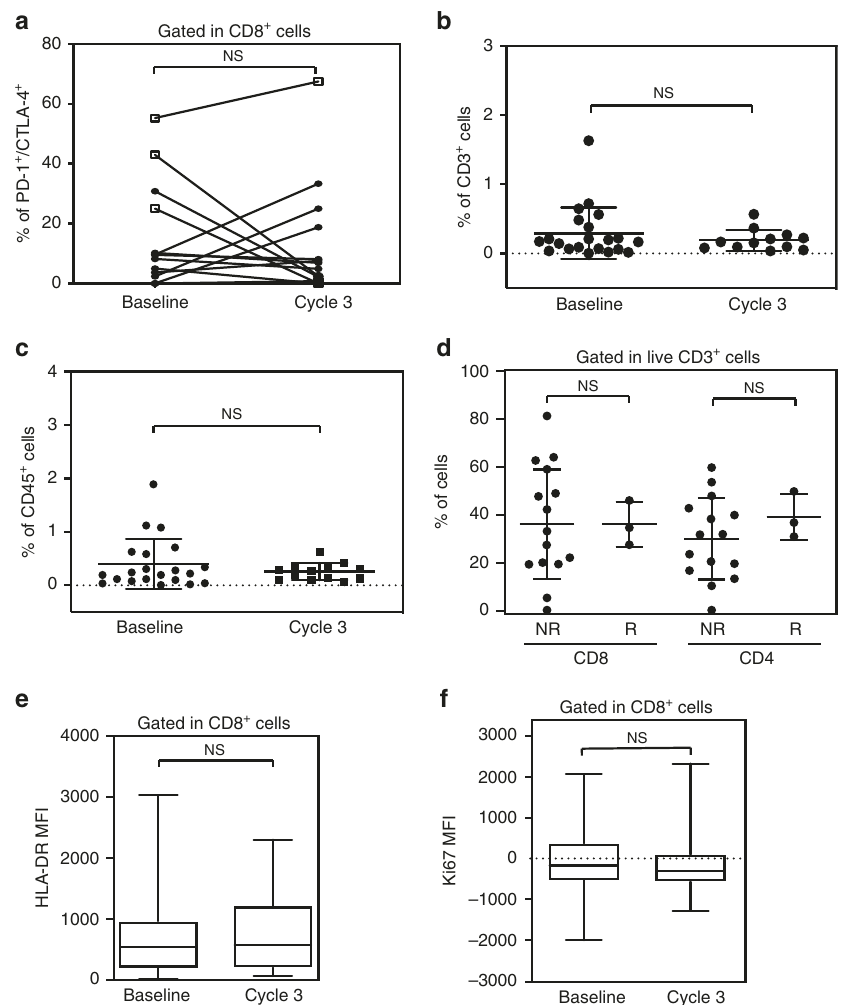
Fig. 3 No signi fi cant change in immune subsets was observed with treatment. a Line plot for fl ow cytometry quanti fi cation of PD-1 + CTLA-4 + live CD8 + T- cells in tumors pre and post therapy on cycle 3. Responders are indicated with an empty square, while non-responders with a full circle ( n = 15). Flow cytometry quanti fi cation of CD3 + ( b ) and CD45 + cells ( c ) at baseline and post treatment. d Flow cytometry quanti fi cation of CD4 + and CD8 + in the tumor microenvironment in non-responders (NR) versus responders (R). Flow cytometric quanti fi cation of HLA-DR ( e ) and Ki67 ( f ) expression in live CD8 + T-cells from metastatic tumors before (Baseline) and after 3 cycles of treatment (Cycle 3) ( n = 14). The markers represent the minimum, fi rst quartile, median, third quartile, and maximum values, respectively ( e , f ). Data are presented as the mean ± SD. Statistical signi fi cance is indicated by p -values as * p ≤ 0.05; ** p ≤ 0.01; **** p ≤ 0.0001; NS = not signi fi cant. This was assessed by two-tailed Wilcoxon text for a – c and e , f and by unpaired T test for